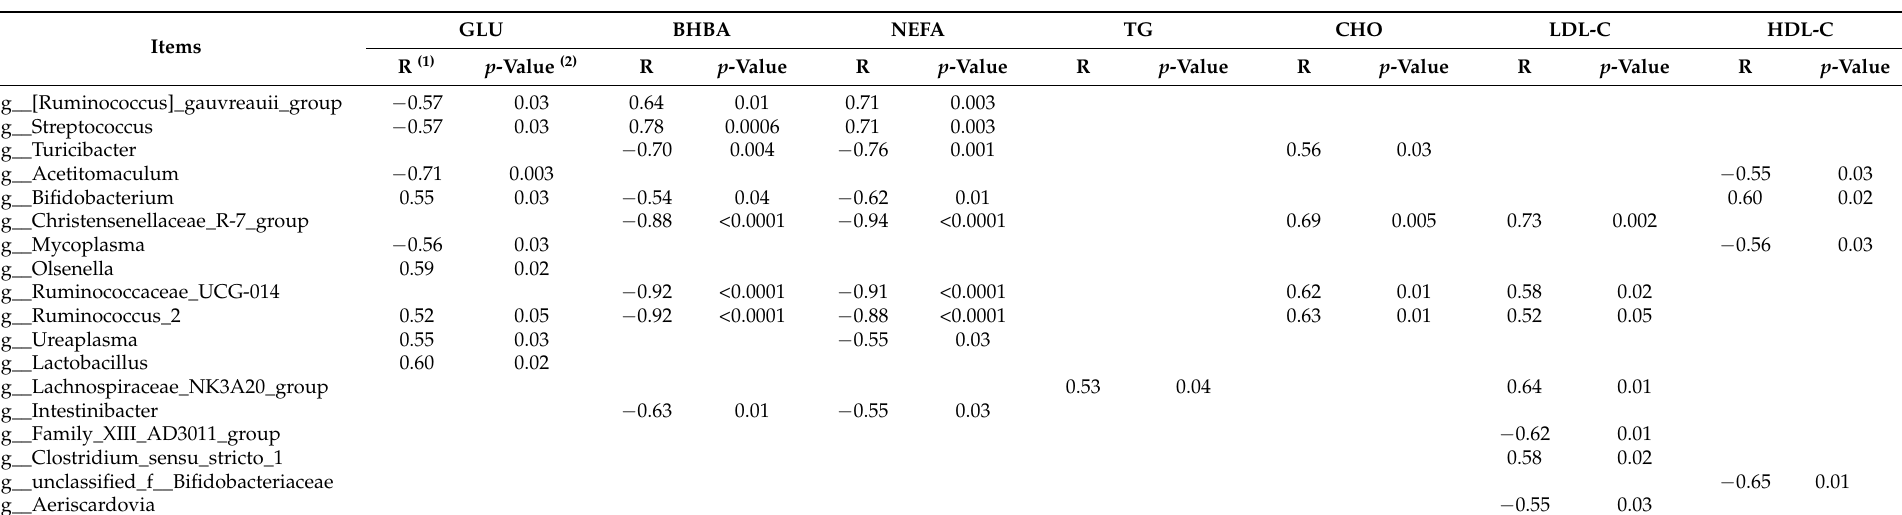
Table 11. Blood lipid profiles showing a Spearman’s correlation with ileal bacterial community.